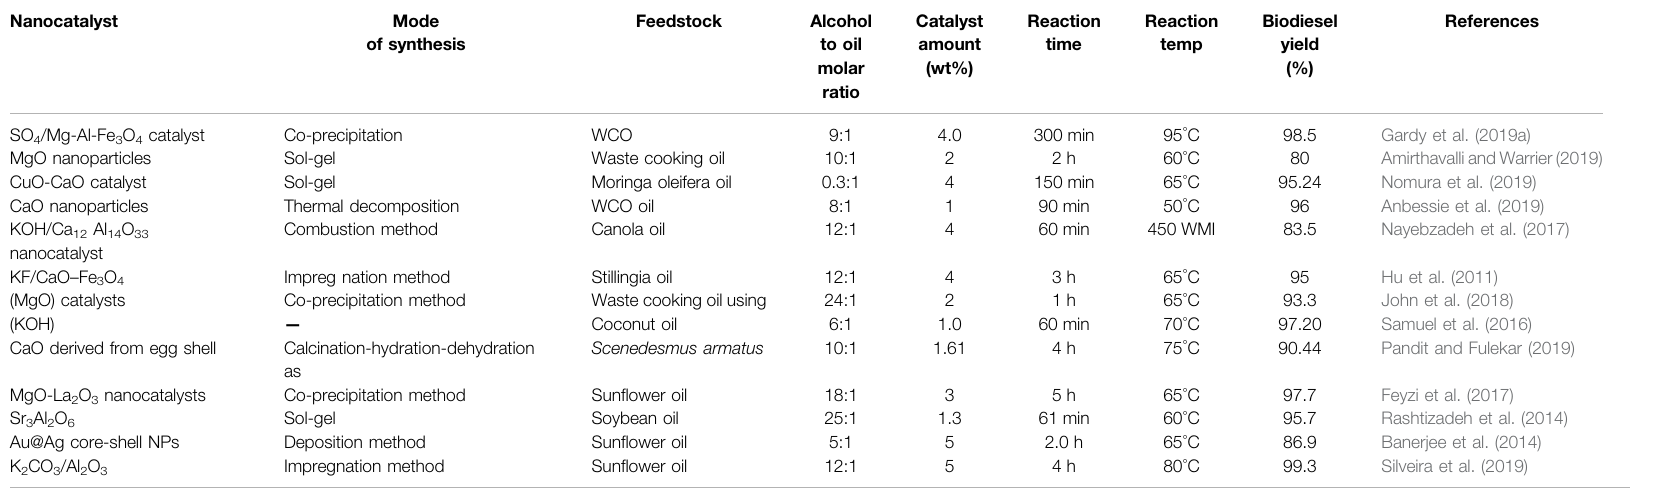
TABLE 8 | Summary of nanocatalysts and optimization parameters used in production of biodiesel.